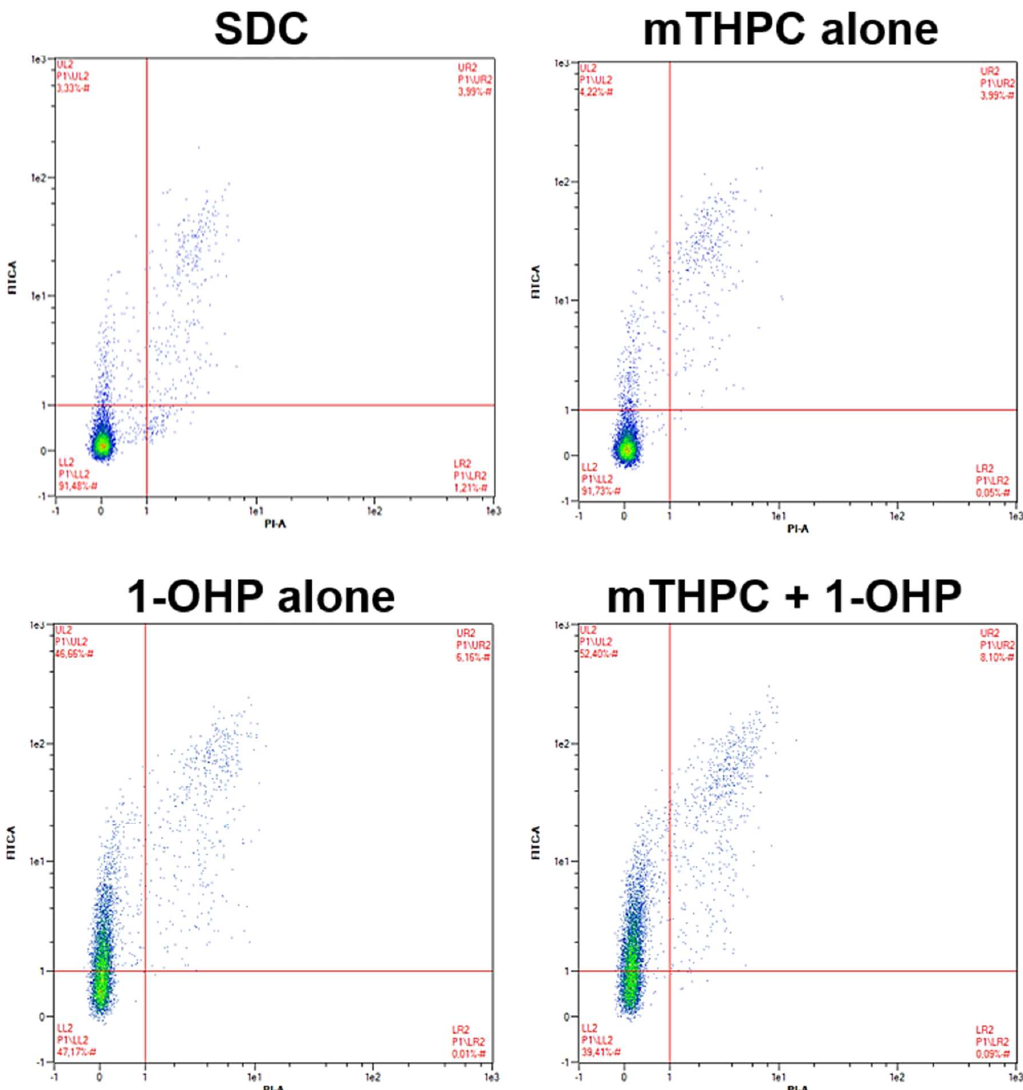
Figure A3. Representative dot plots after flow cytometric analysis of apoptosis induction in SISO cells. Cells were treated with a solvent dark control (SDC), mTHPC or 1-OHP alone, or a combination of mTHPC and 1-OHP prior to illumination with 1.8 J/cm 2 . Double staining with Annexin V-FITC and propidium iodide (PI) was carried out 48 h after illumination. For each sample, 10,000 events were counted and gated for the single cell population (not shown). Unstained, vital cells appear in the lower left quadrant, Annexin V-FITC-positive (apoptotic) cells in the upper left quadrant and Annexin V-FITC- and PI-positive (late-apoptotic/necrotic) cells appear in the upper right part. The B1 channel ( λ Ex/Em = 488 nm/525–550 nm) of a MACS Quant flow cytometer was used for the detection of Annexin V-FITC and the B3 channel ( λ Ex/Em = 488 nm/655–730 nm) was used for the PI signal. Data were analysed with the MACS Quantify Software.